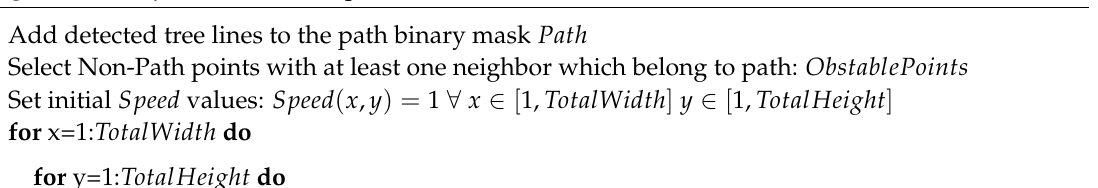
Algorithm 11 Speed = CalculateSpeed{ Path , SortedTreeLines } Add detected tree lines to the path binary mask